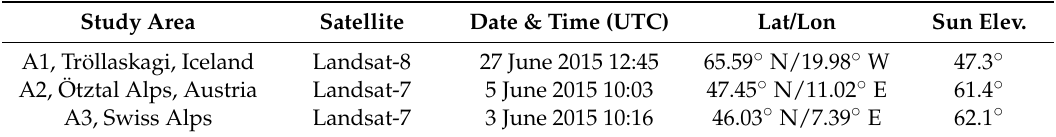
Table 2. Information on the Landsat scenes used for comparison with S1 snow maps. Latitude, longitude and sun elevation refer to the scene